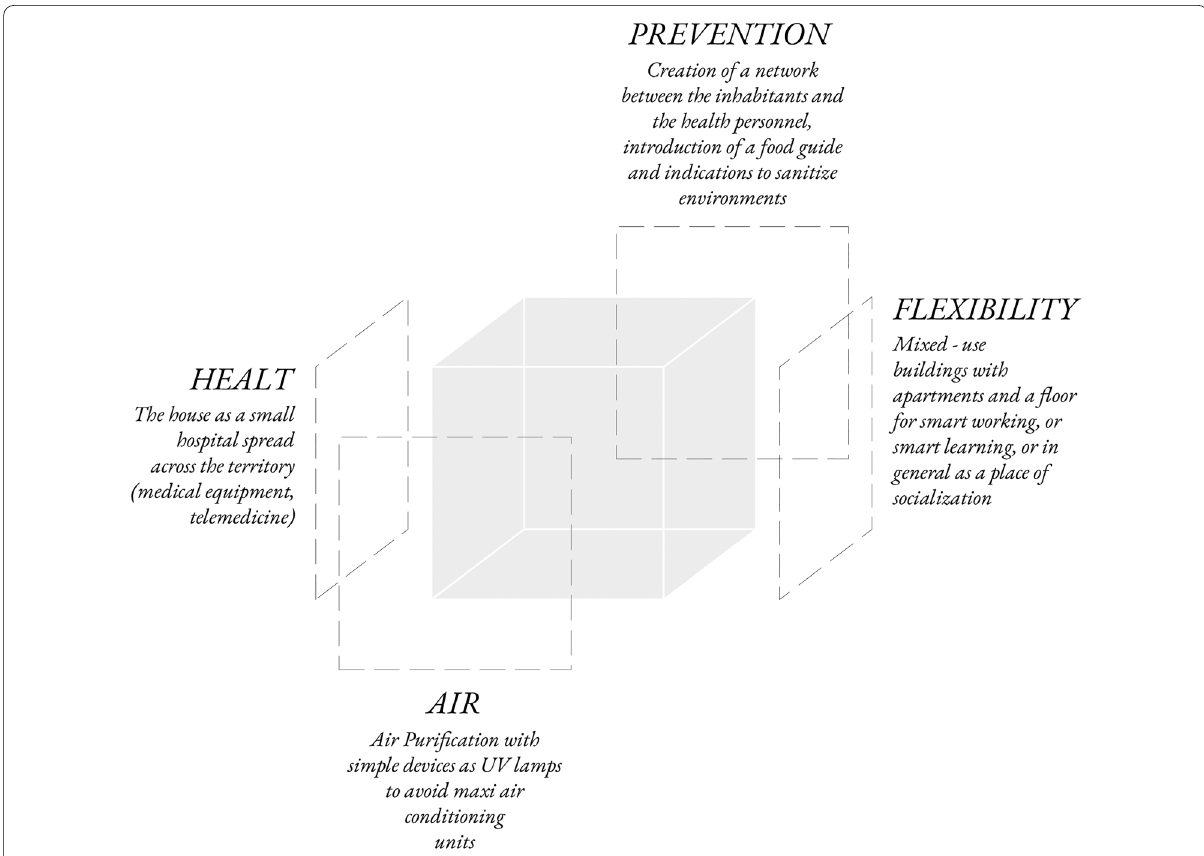
Fig. 2 Scheme of Post-Covid House , M. Fuksas, 2020